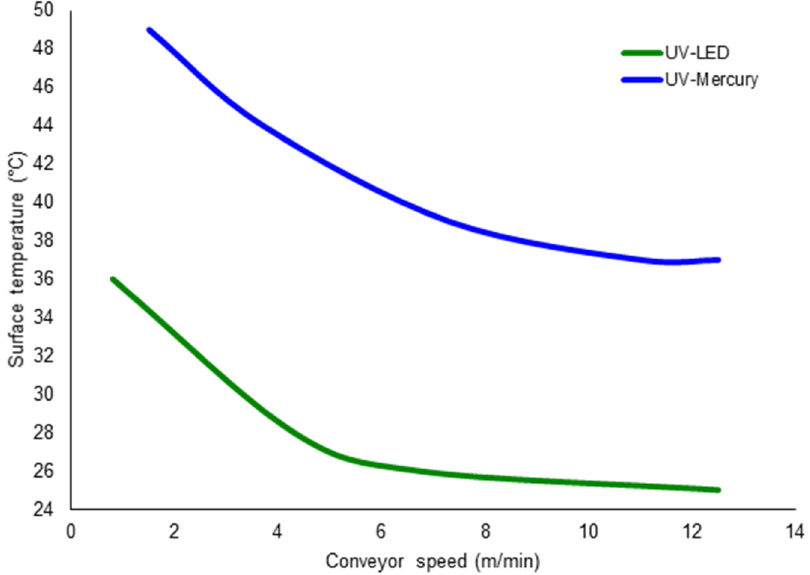
Figure 2. Surface temperature obtained with the two lamps in function of the conveyor